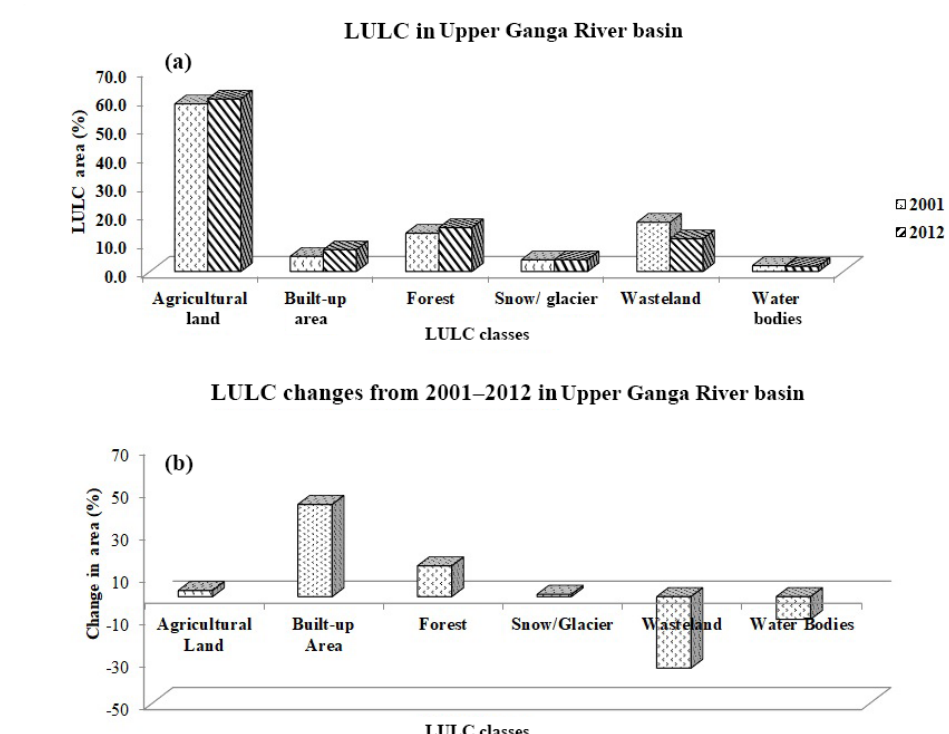
Figure 5. Graph showing LULC distribution of the years 2001–2012. (a) LULC area in percentage (%) and (b) LULC changes from 2001 to 2012 in Upper Ganga River